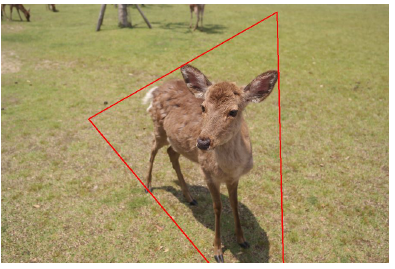
Figure 11. The smallest triangle that can contain the foreground.